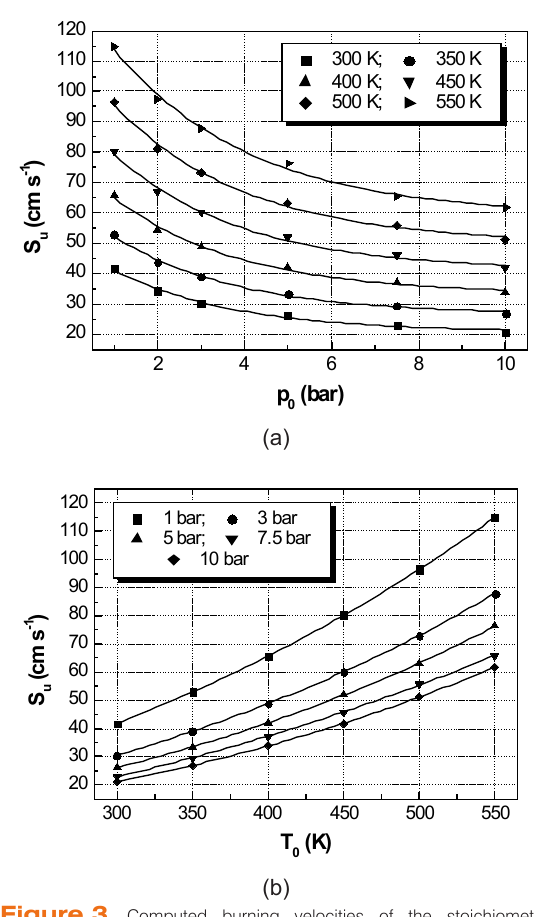
Figure 3. Computed burning velocities of the stoichiometric ethane-air mixture. (a) Burning velocities at various initial pressures; (b) Burning velocities at various initial